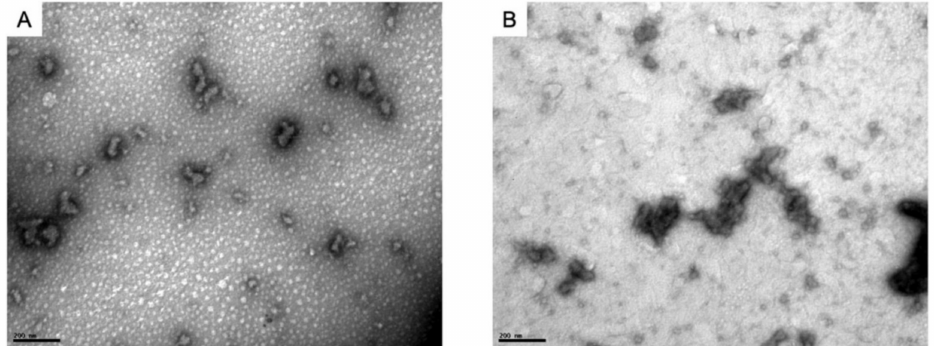
Figure 26. TEM images were obtained for the design nanoparticles. Both freshly prepared nanoparti- cles are in pH 3.0 ( A )—5F/1C (5:1 ratio of the F and CS NPs) and ( B )—MTX-loaded 5F/1C). Scale bar: 200 nm [165]. Reproduced with permission from Elsevier